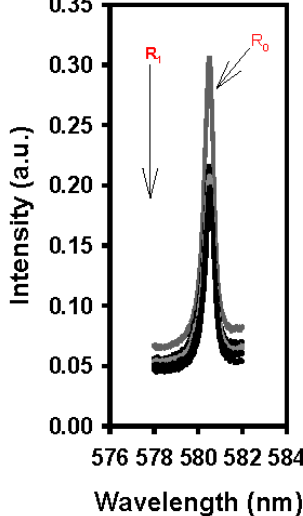
Figure 3. R 1 : 5 D 0 ← 7 F 0 (Eu) excitation spectra for solutions containing 0.005 M [Eu(DPA) 3 ] 3 − , 40 equiv. L -serine with solvent ratios (H 2 O:formamide) from 90:10 to 50:50. R 0 : 5 D 0 ← 7 F 0 (Eu) excitation spectra for the control containing 0.005 M [Eu(DPA) 3 ] 3 − , 0 equiv. L -serine, and 50:50 H 2 O:formamide.